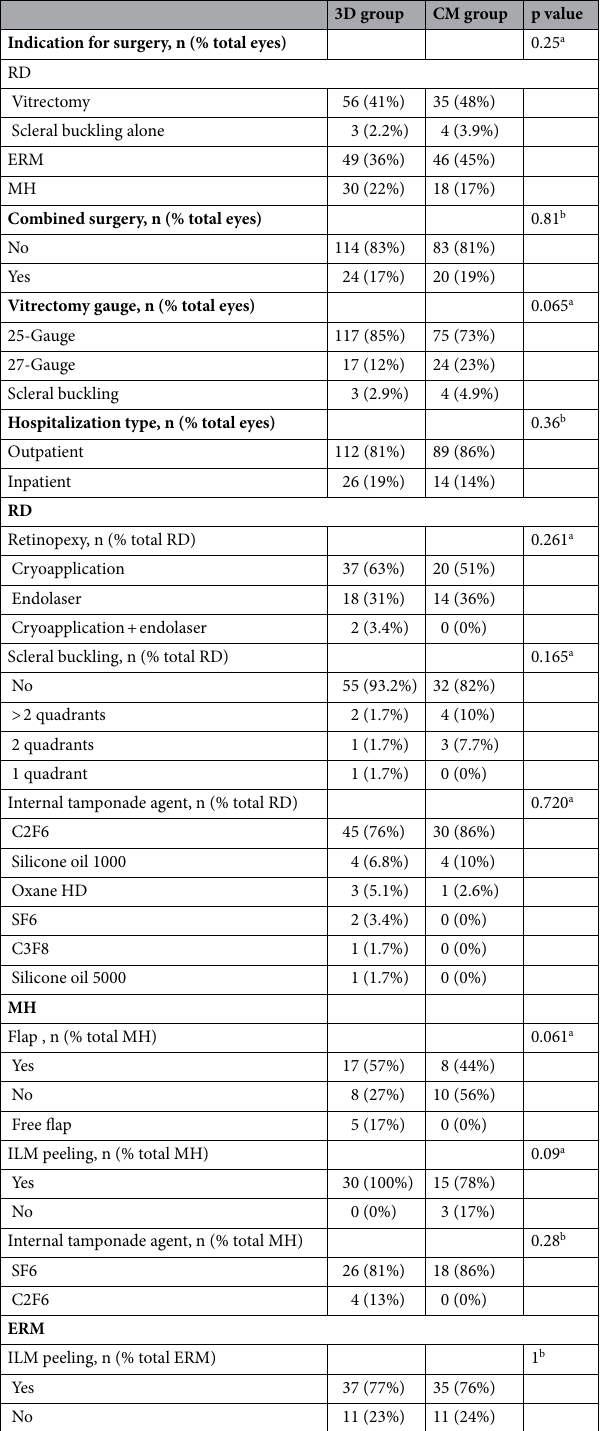
Table 2. Indications for surgery and the surgical techniques performed in the three-dimensional (3D) and conventional microscopy (CM) patient groups. ERM epiretinal membrane, ILM internal limiting